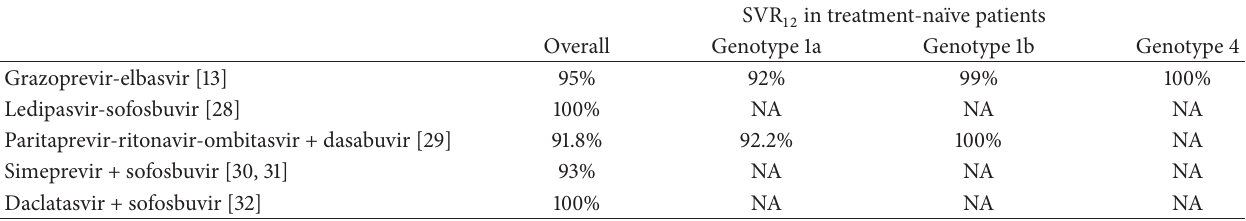
Table 1: SVR 12 rates of first-line therapies for the treatment of HCV genotypes 1a, 1b, and 4 [13, 28–32].